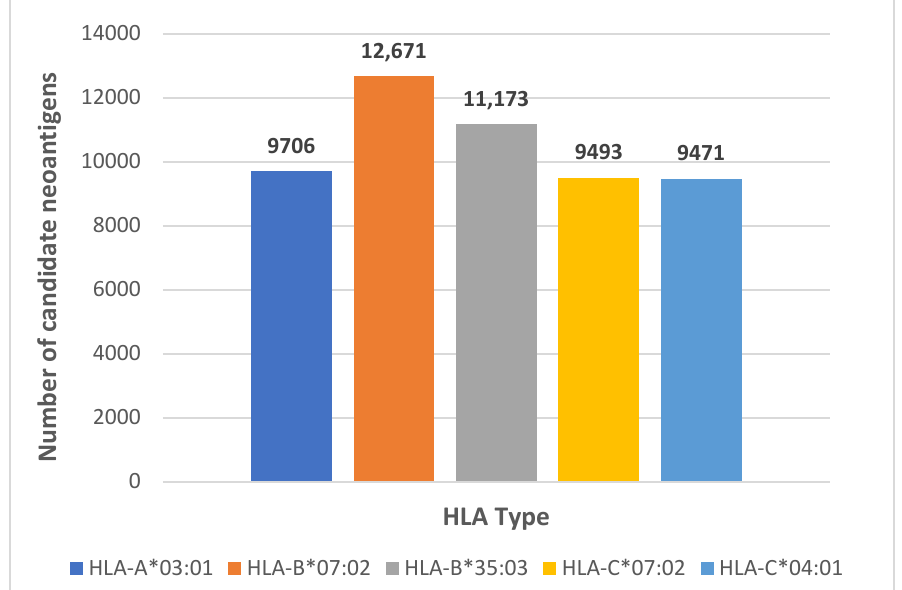
Figure 4. The number of predicted neoantigens bound to each HLA allele.